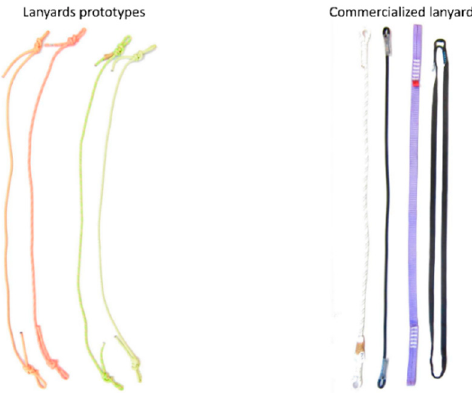
Figure 4. Prototypes ( left ) and commercialized lanyards ( right ).